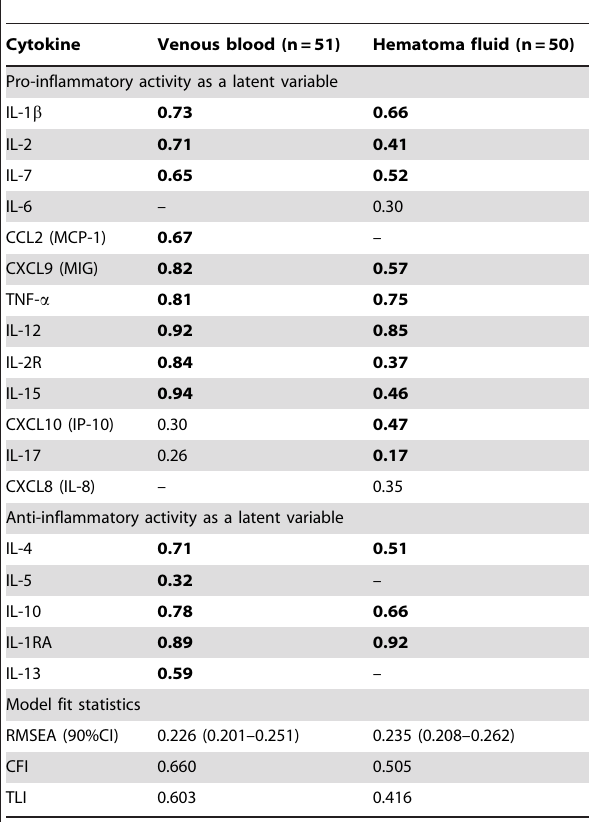
Bold letters indicate statistically significant (p , 0.05) standardized loadings with an absolute value above 0.4. Cytokines with non-significant loadings were excluded from the final model.